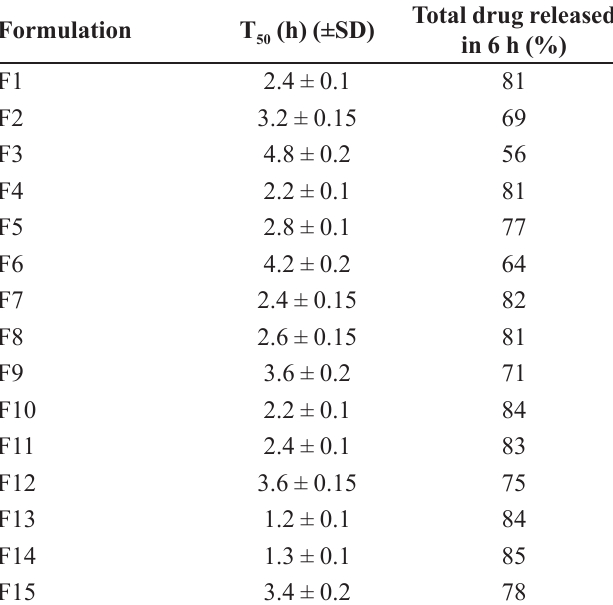
TABLE III - Time for 50% drug release and cumulative %age of drug released in 6 h Formulation